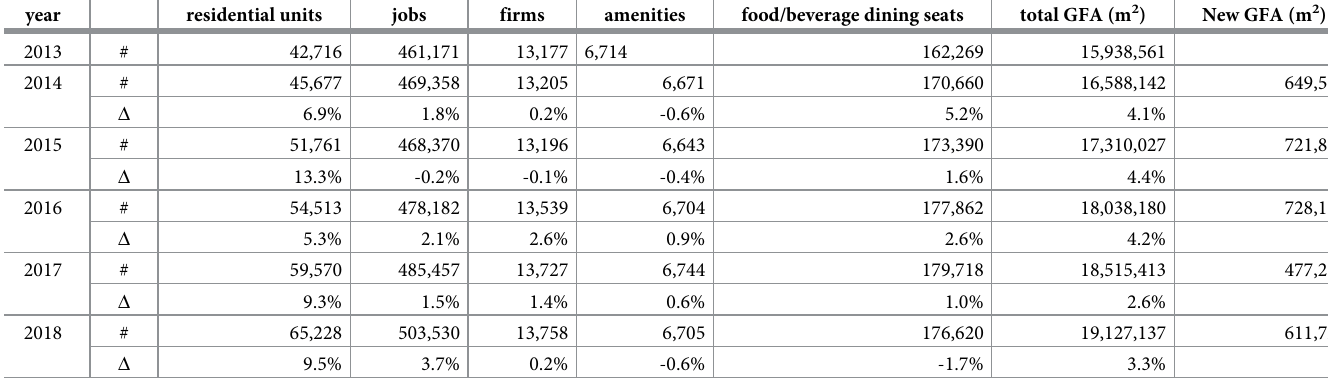
Table 1. Change in built environment in Melbourne CBD, 2014–2018. (Source: City of Melbourne